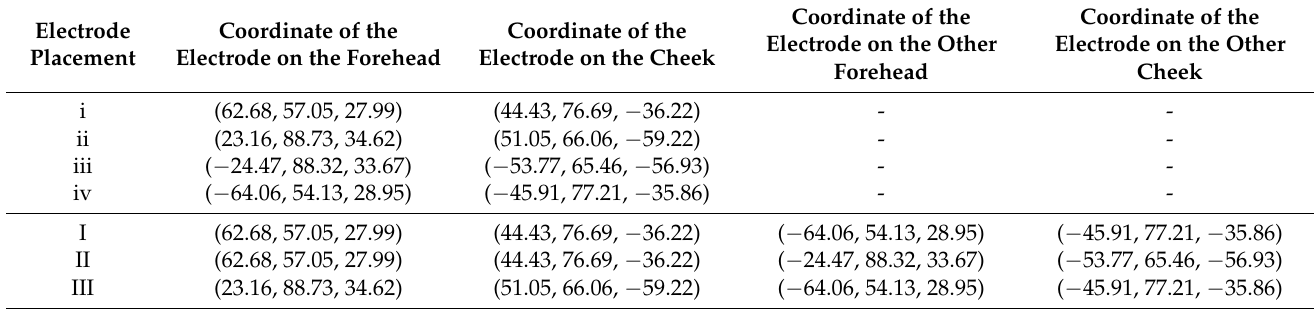
Table 4. The coordinates of each electrode placement used in the second simulation